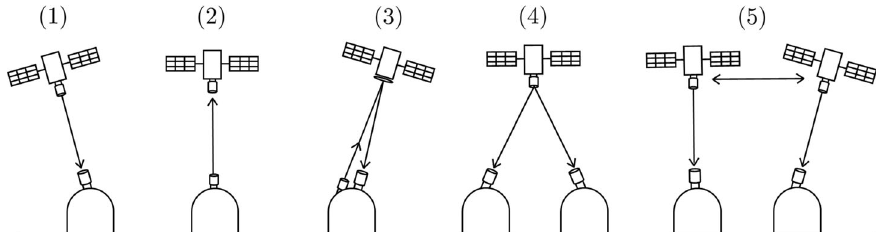
Fig. 2 Illustration of different platforms for performing satellite QKD. Scenarios (1) and (2) depict a downlink and an uplink, respectively, while in scenario (3) a downlink is simulated by using a retro-re fl ector on board the satellite. In (4) pairs of entangled photons are being transmitted to Earth so that two ground stations can share entangled states. Finally, scenario (5) illustrates how inter-satellite links can allow more complex satellite QKD